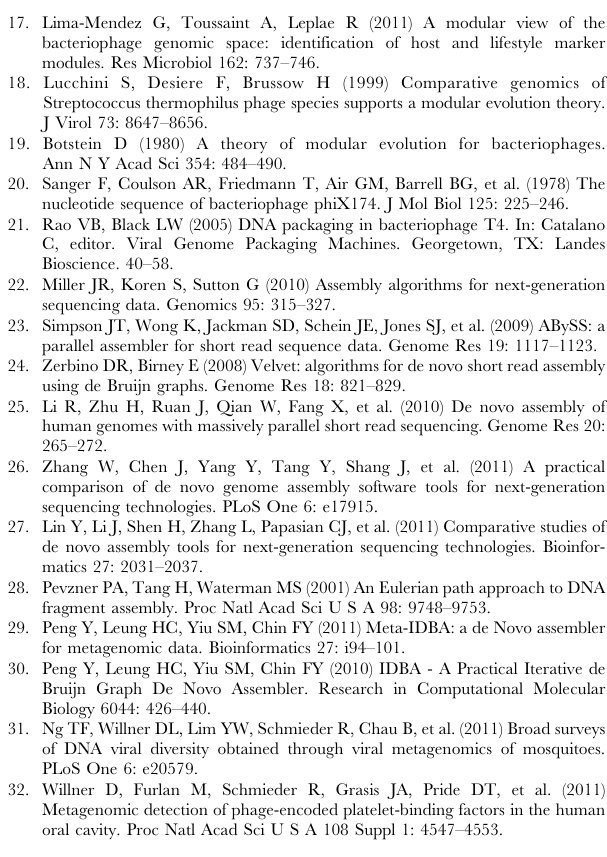
Figure S1 Optimized iterative de Bruijn graph assem- bly of 10 7 viral metagenomic sequences. A) Summary of run statistics for each iteration of the assembly, in which reads mapping to newly assembled contigs were removed at each iteration. The horizontal axis indicates the iteration number. For each of those iterations, the vertical axes indicate the number of reads remaining at the end of the iteration, the number of reads mapped during that iteration, the number of contigs made, the number of circular contigs made, and the optimal kmer chosen for that iteration. B) Characteristics of contigs by iteration of assembly. Each point is a contig with a length shown on the horizontal axis, depth of the assembly is shown on the vertical axis, and the iteration at which it was assembled indicated by color. The contigs that were assembled at earlier cycles (shown with bluer points) are generally longer and more deeply sequenced. Figure S2 Comparison of assembly methods by known genome reconstruction. Shotgun sequences from HPV Type 6b were extracted from one dataset and added back to another dataset lacking HPV in varying amounts, as indicated in the grey